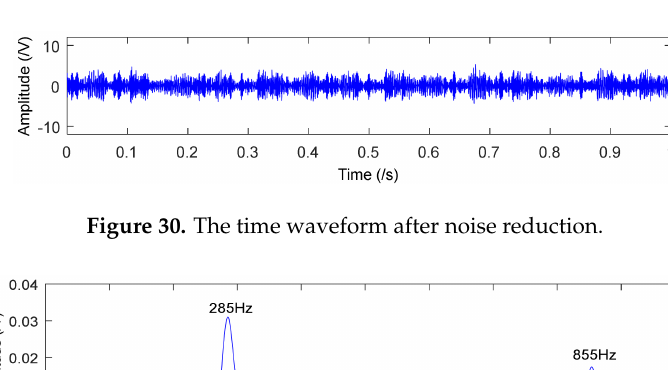
Figure 29. The time waveform of the original signal.